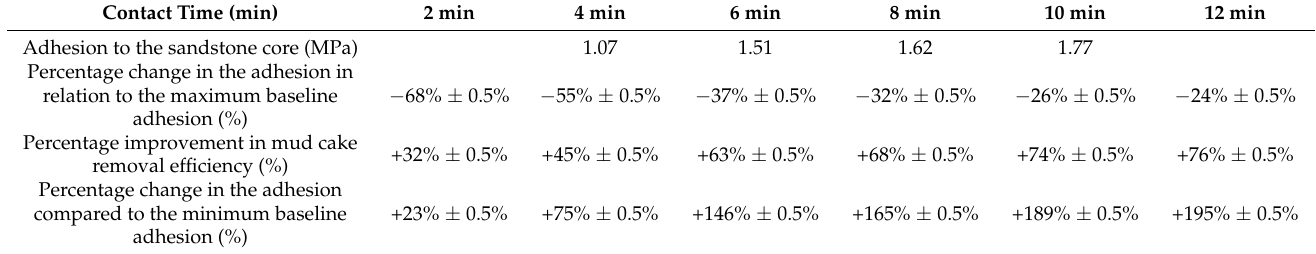
Table 4. Adhesion between the bound cement and the rock for different wash contact times.